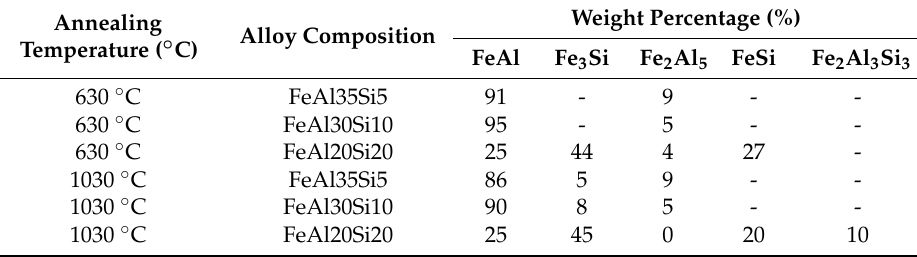
Figure 9. DTA heating curve of MA (4 h) sample depending on the chemical composition of powder. Table 6. Phase composition of the powders vs. annealing temperature and alloy composition.